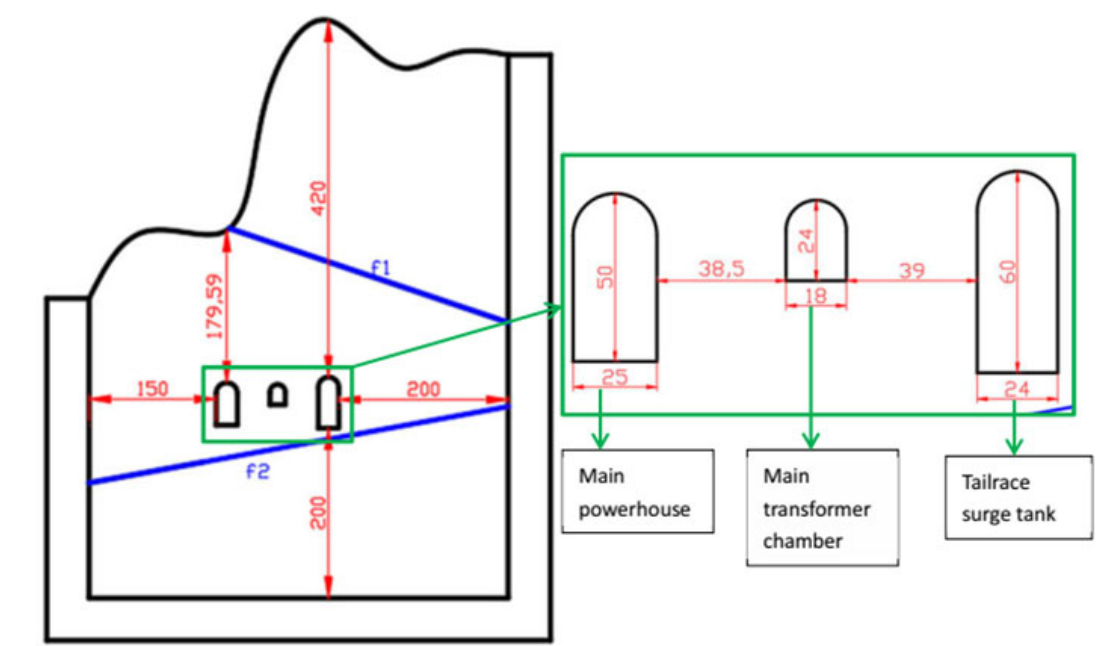
Figure 1. Geometric dimensions (m) of the model.